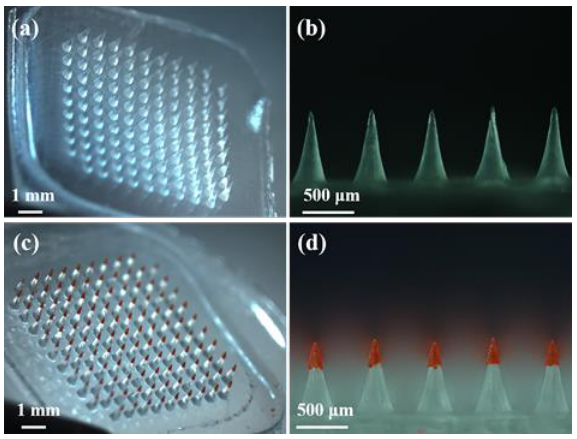
Figure 3. ( a ) Stereomicroscopic image of water-soluble MNs. ( b ) Side view of water-soluble MNs. ( c ) Stereomicroscopic image of FR-loaded IPMNs. ( d ) Side view of FR-loaded IPMNs.